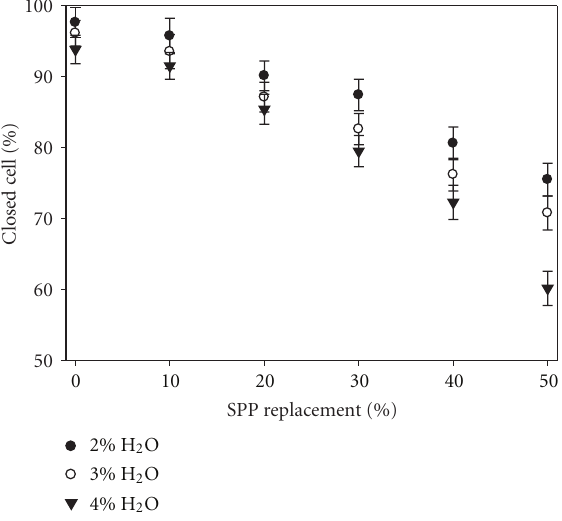
Figure 3: E ff ect of SPP percentage on closed cell percentage of rigid PU foams with di ff erent water